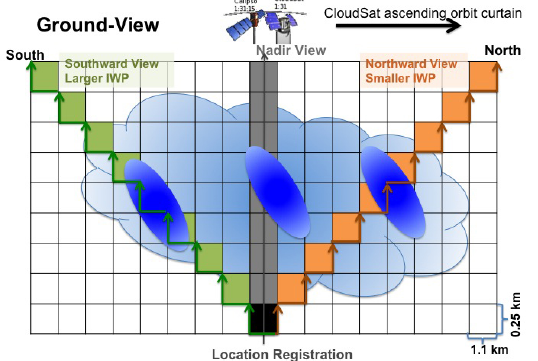
Figure 7. A diagram showing the computation geometry of the ground view.